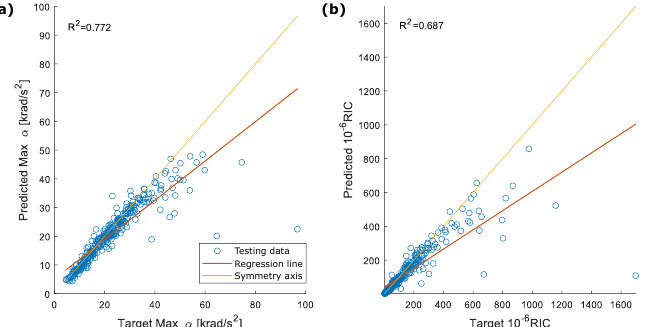
Figure 10. Correlation between ( a ) target and predicted peak for the resultant rotational acceleration and ( b ) target and predicted